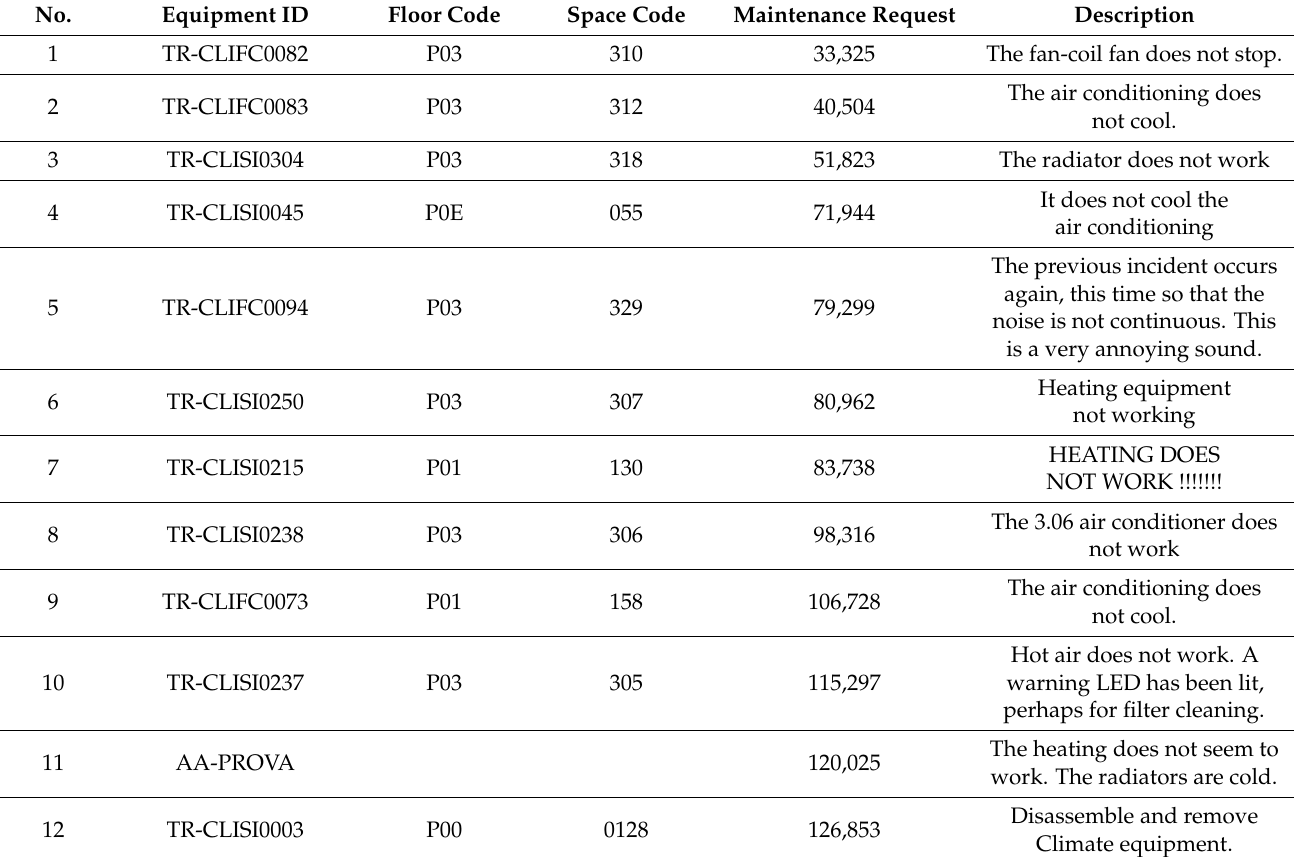
Table 2. Example of HVAC maintenance requests in